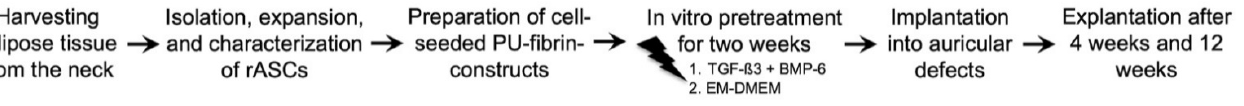
Figure 1. Procedure of the in vivo studies with New Zealand White